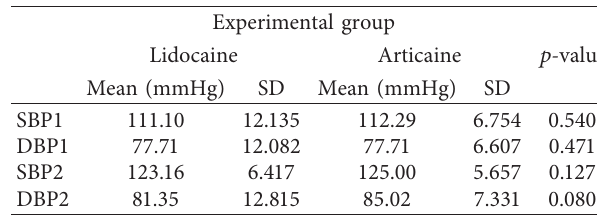
Table 1: Mean values of systolic and diastolic blood pressures before and after lidocaine and articaine injection.